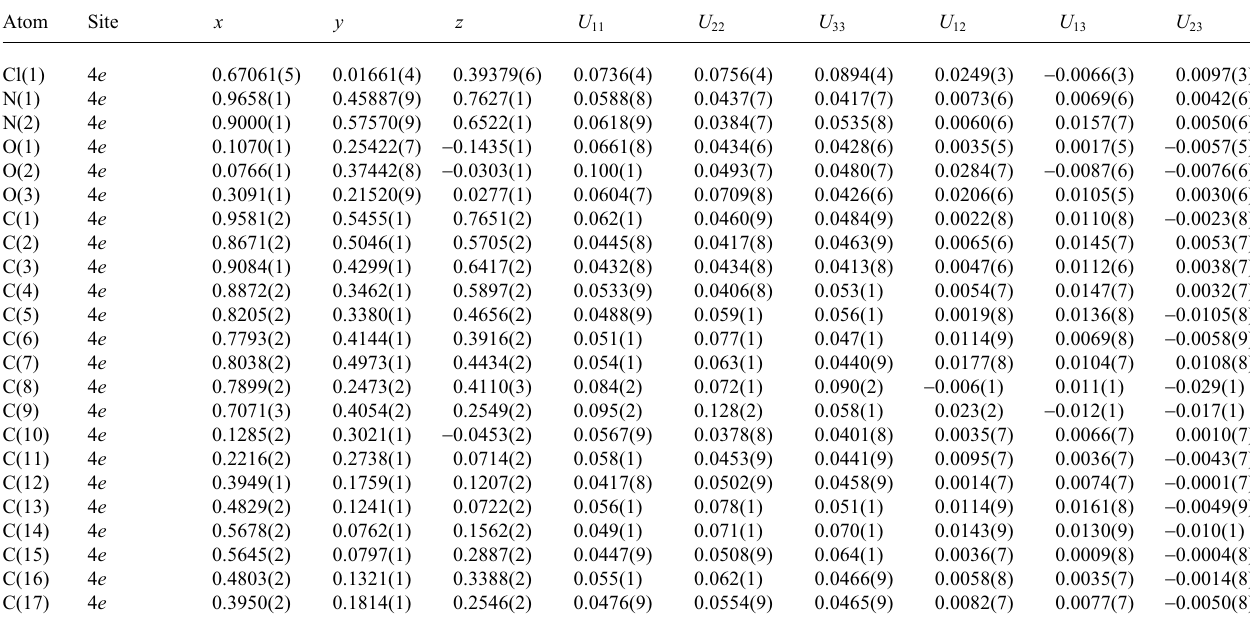
Table 3. Atomic coordinates and displacement parameters (in Å 2 )